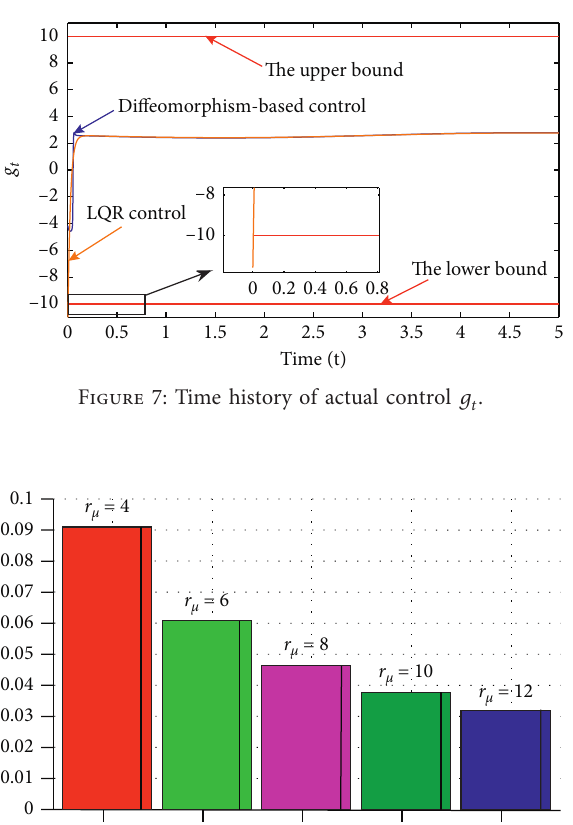
Figure 8: Comparison of the accumulative error for state x choosing different c